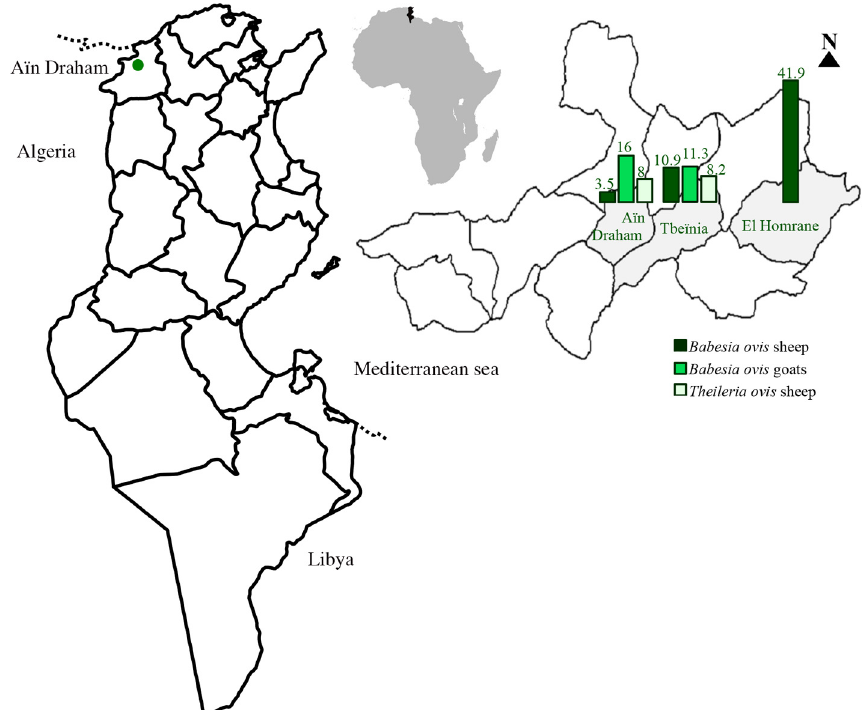
Figure 1. Sheep and goat PCR infection prevalence of Babesia ovis and Theileria ovis in the Aı¨n Draham locality (North-West